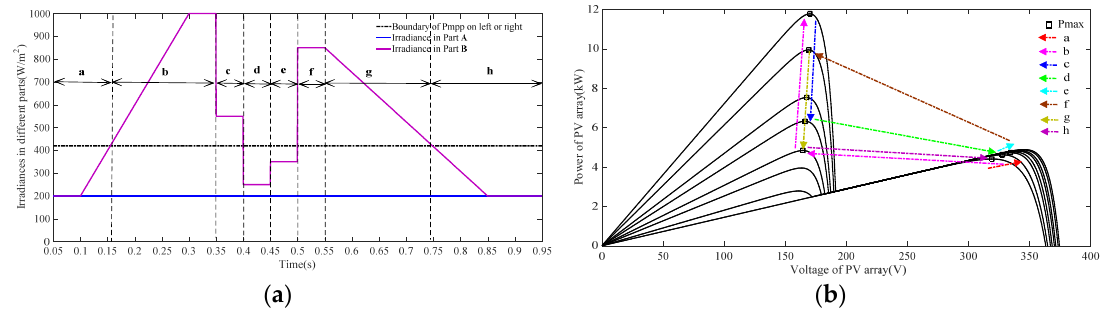
Figure 9. ( a ) Irradiances of different parts of the PV array; ( b ) voltage of the PV array. It can be seen from Figure 9 that during the simulation the irradiance can change gradually or abruptly. The amplitude of the MPP voltage also deviates frequently by more than 150 V; that is, the MPP keeps moving between the left and right peaks with changes in irradiance. The MPP is on the right peak in area a of Figure 9A. As the irradiance increases, the MPP moves to the left peak at 0.16 s The peaks under 200 V in Figure 9 are defined as the left peaks and the peaks above 200 V are defined as the right peaks. irradiance decreases from 1000 W/m 2 to 550 W/m 2 suddenly. At 0.4 s, the MPP on the left peak shifts to the right peak when the irradiance decreases from 550 W/m 2 to 250 W/m 2 , as shown in area d of Figure 9A. At 0.45 s, 0.5 s, 0.55 s, and 0.74 s, the irradiance changes as shown in Figure 9a, accompanied by a shift of the MPP from the left peak to the right peak.